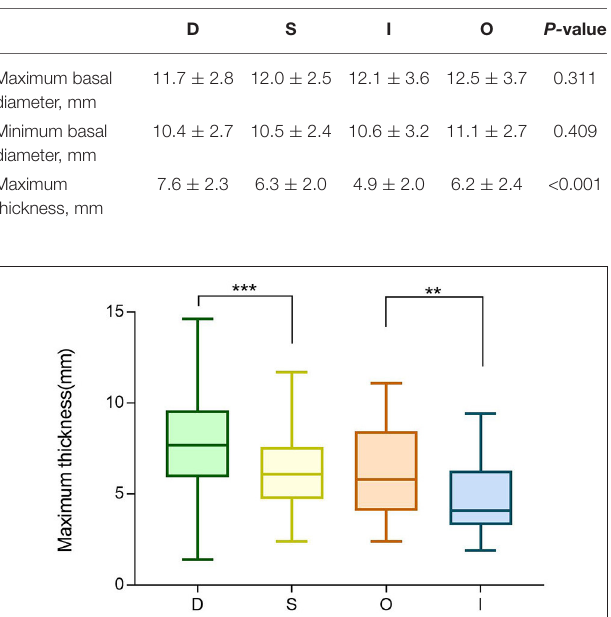
TABLE 1 | Preoperative tumor size of different patterns.